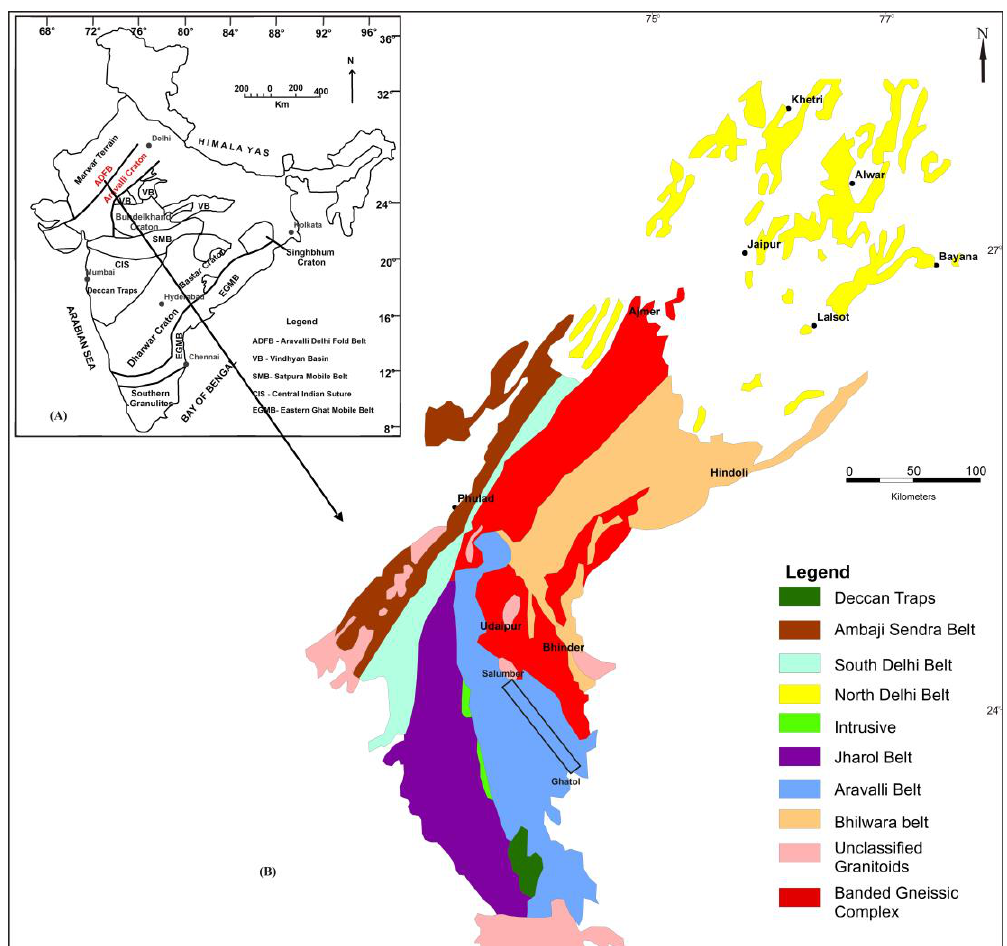
Figure 1. ( A ) Inset map showing the location of the Aravalli craton and Aravalli Delhi Fold Belt in Indian subcontinent, modified from reference [43]; ( B ) Geological map of the Aravalli–Delhi Fold Belt showing location of the basement Banded Gneissic Complex (BGC), Paleoproterozoic Aravalli Supergroup and Salumber-Ghatol metallogenic belt, modified from references